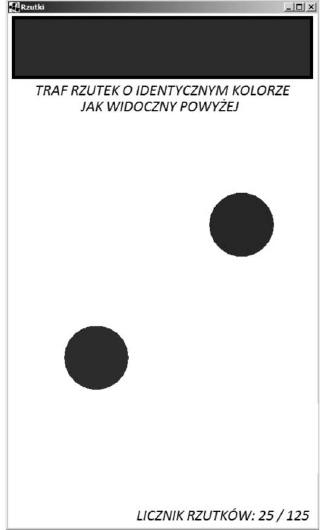
Figure 4. Interface of the ColorSkeet game (source: own